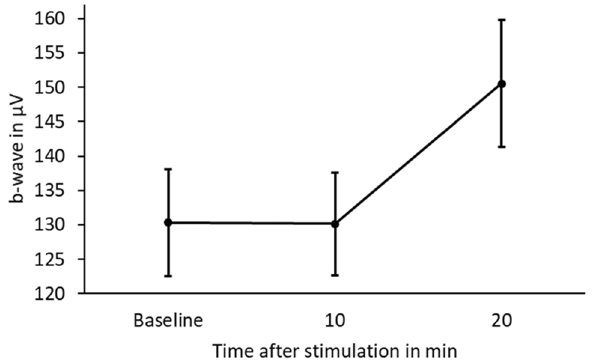
Figure 2. Mean and standard error of the mean (SEM) of b-wave in µV for baseline and 10 and 20 min after blue light stimulation of the blind-spot in 10 myopes.